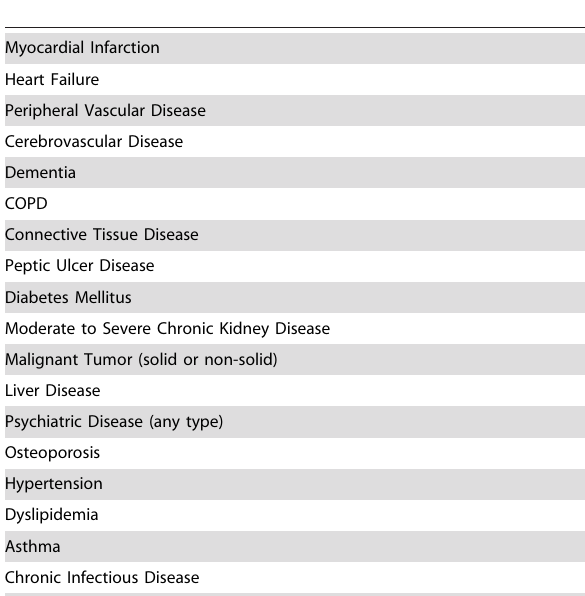
Table 1. List of